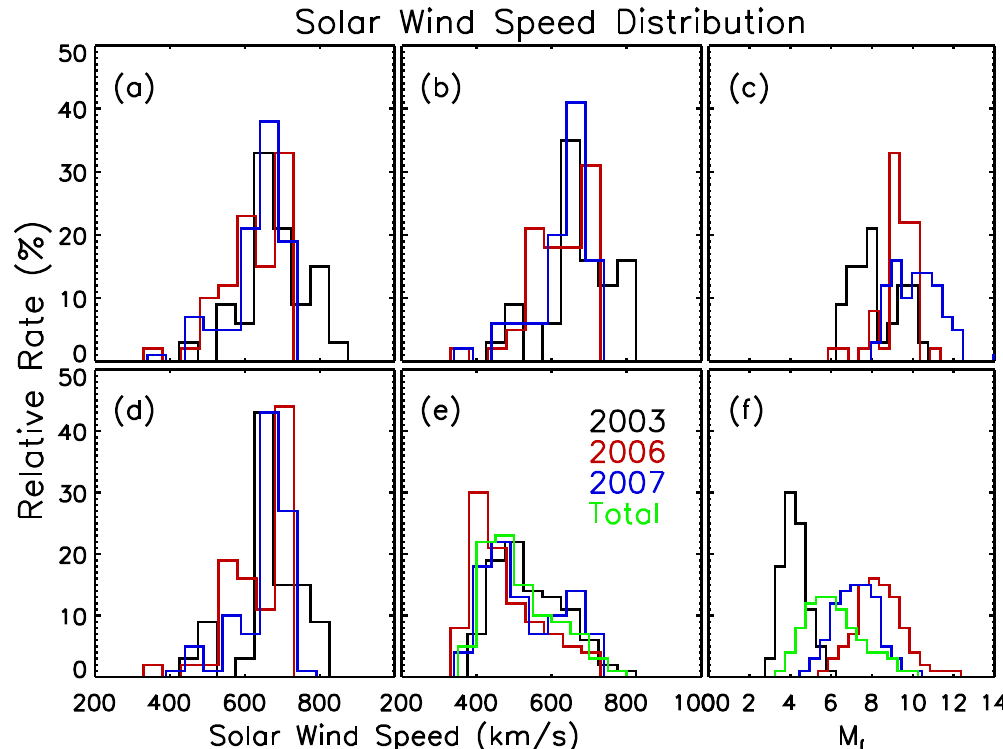
Fig. 9. Solar wind speed distribution measured by Cluster and ACE spacecraft. Black, red, blue and green refers to measurements in 2003, 2006, 2007 and 1998–2008, respectively. The figure shows the solar wind speed distribution measured by (a) Cluster-1 CIS HIA during HFA formation. (b) by Cluster-3 CIS HIA, and (d) by ACE SWEPAM; it also shows. Fast magnetosonic Mach number distribution calculated using ACE MAG and SWEPAM data during HFA formation (c) , solar wind speed distribution measured by ACE SWEPAM from February